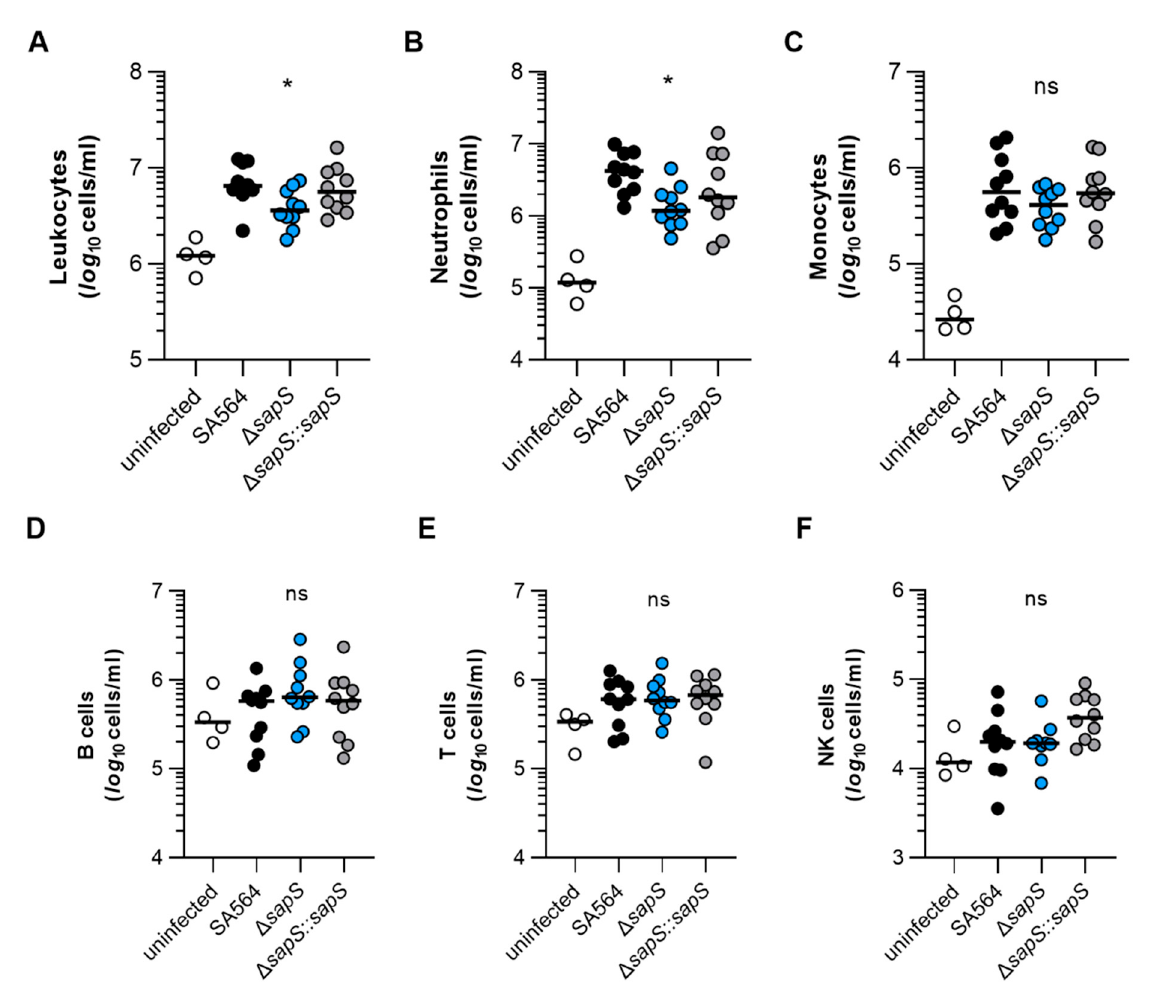
Figure 5. The impact of SapS on the immune cell composition observed in the blood of mice infected with S. aureus . C57BL/6N mice were infected with S. aureus strain SA564 (black symbols), SA564 ∆ sapS (blue symbols), and the cis -complemented derivative SA564 ∆ sapS::sapS (grey symbols), respectively (n = 10 per group). After 4 days of infection, blood was withdrawn from narcotized mice, red blood cells lysed, the residual blood cells stained with fluorochrome-conjugated antibodies and the cell contents of leukocytes ( A ), neutrophils ( B ), monocytes ( C ), B cells ( D ), T cells ( E ), and NK cells ( F ) determined by flow cytometry. Blood from age-matched uninfected mice served as control (white symbols). Each symbol represents the cell content obtained from the blood of an individual mouse. The median of all the observations is shown by the horizontal bar. ns, not significant; * p < 0.05 (Kruskal–Wallis test followed by Dunn’s post hoc test. Only significant differences between WT-infected and mutant-infected mice are